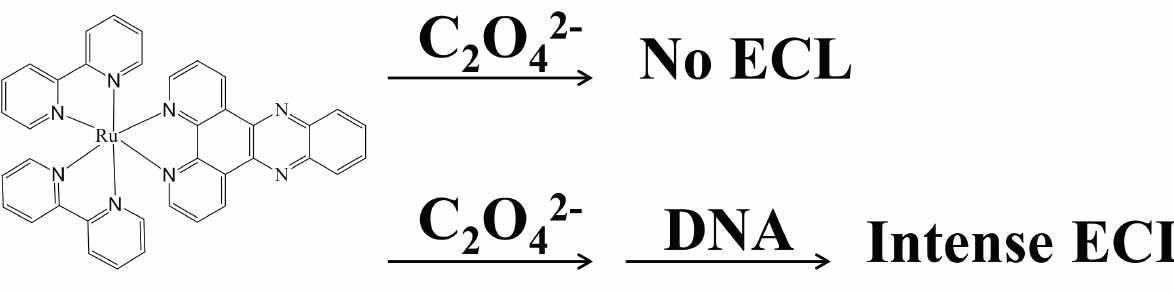
dppz] 2+ and DNA. Reprinted with 2